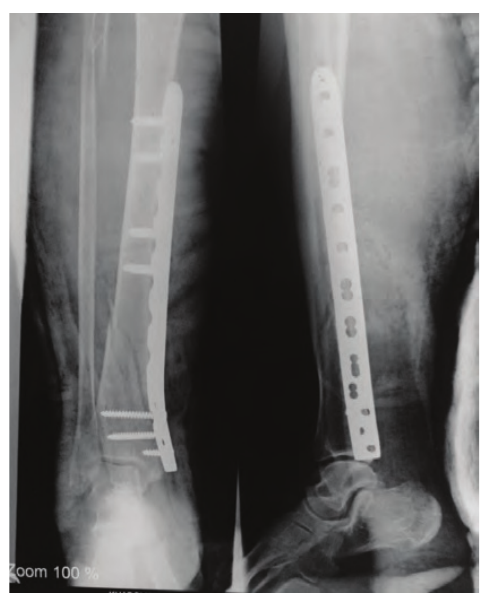
Figure 6: Twelve weeks after surgery, with bridging